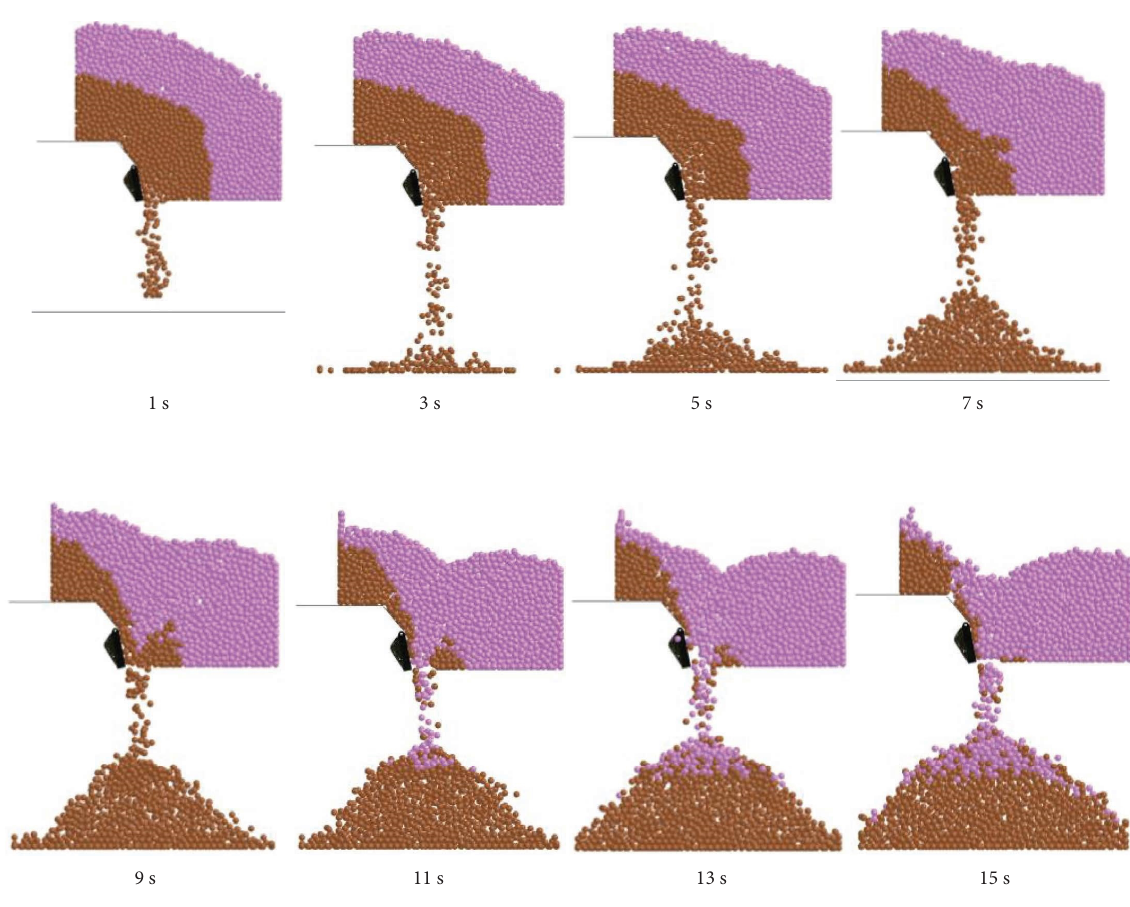
Figure 22: Te coal-caving process when the mining and caving ratio is